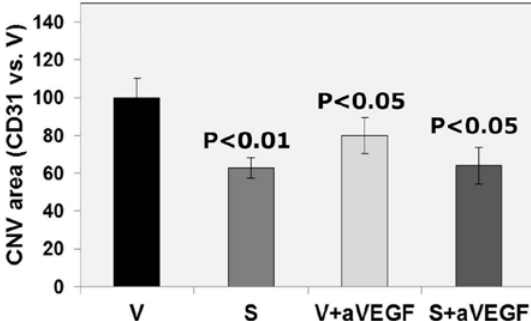
Figure 3. Area of choroidal neovascularization (CNV), as measured with CD31 immunofluorescence. The area of CNV was smaller in all treated groups (nutritional supplement (S, p < 0.01), supplement and anti-vascular endothelial growth factor agent (S + aVEGF, p < 0.05), and vehicle and anti-VEGF agent (V + aVEGF, p < 0.05)) than in the vehicle (V) group. There were 15 animals in each group and data are expressed as mean ± standard error of the mean.